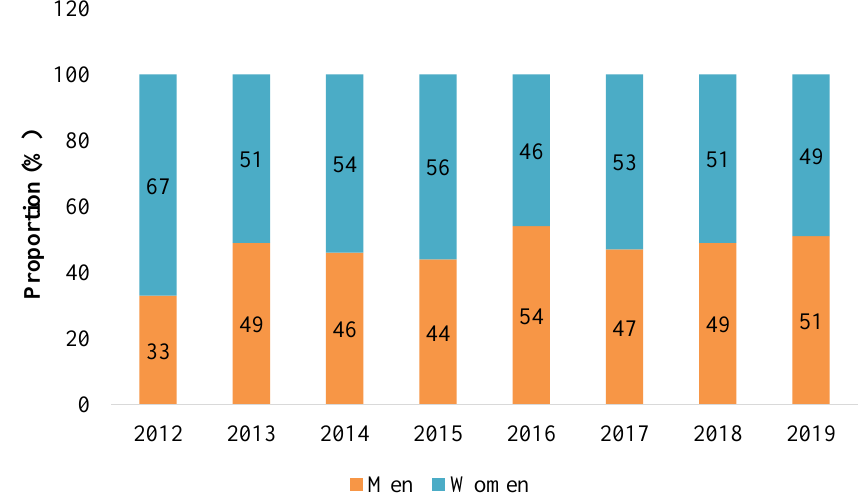
Fig. 2. Results of structural analysis of the LGM population during 2012-2018 (results of forecasting of relevant indicators in